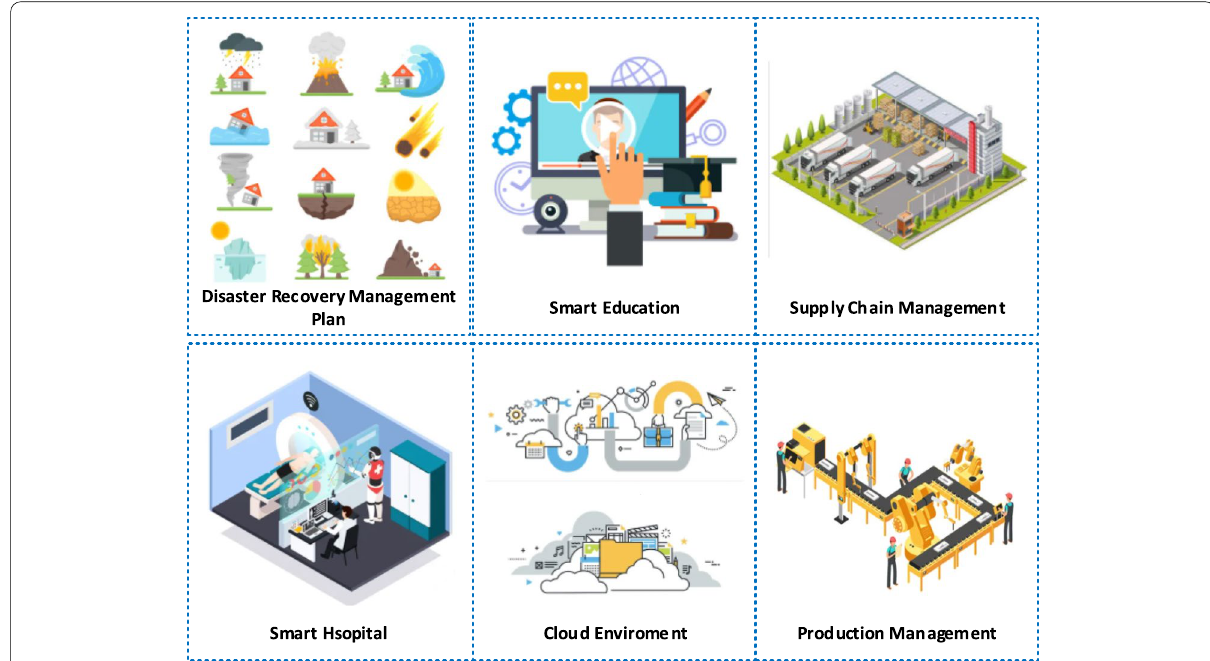
Fig. 2 Applications of Industry